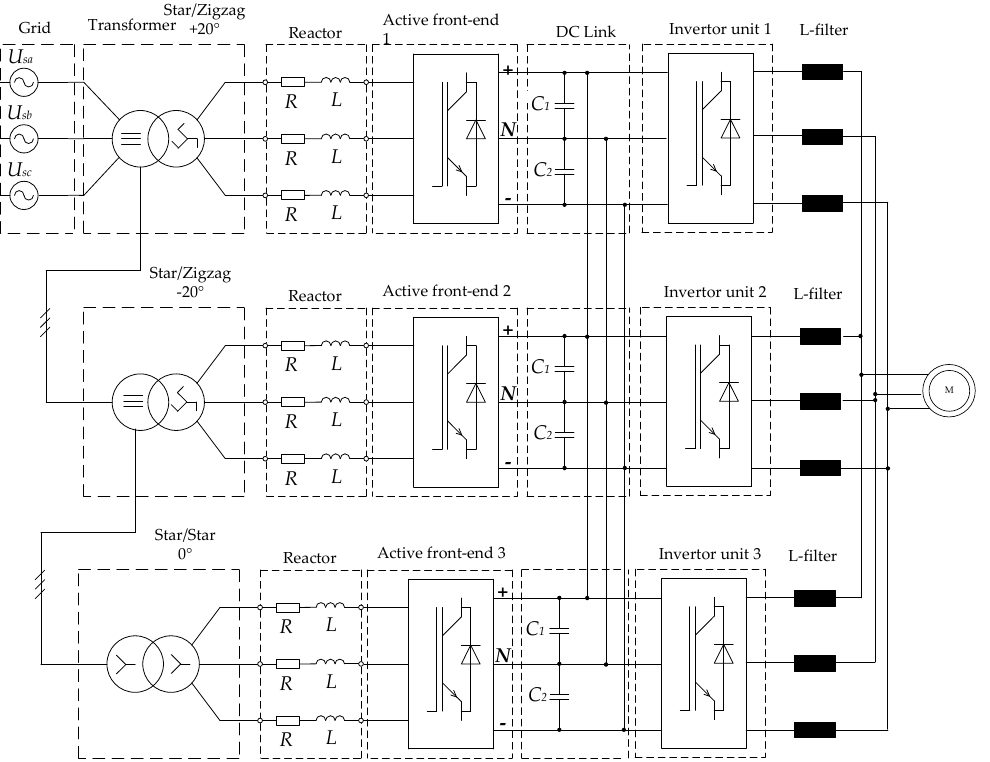
Figure 4. The 18-pulse grid connection circuit based on a multi-winding phase-shift transformer with a series connection of primary